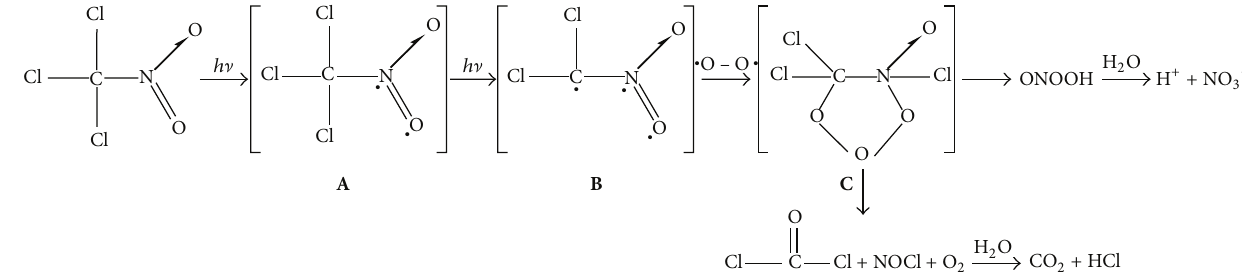
Figure 8: Proposed mechanisms for TCNM